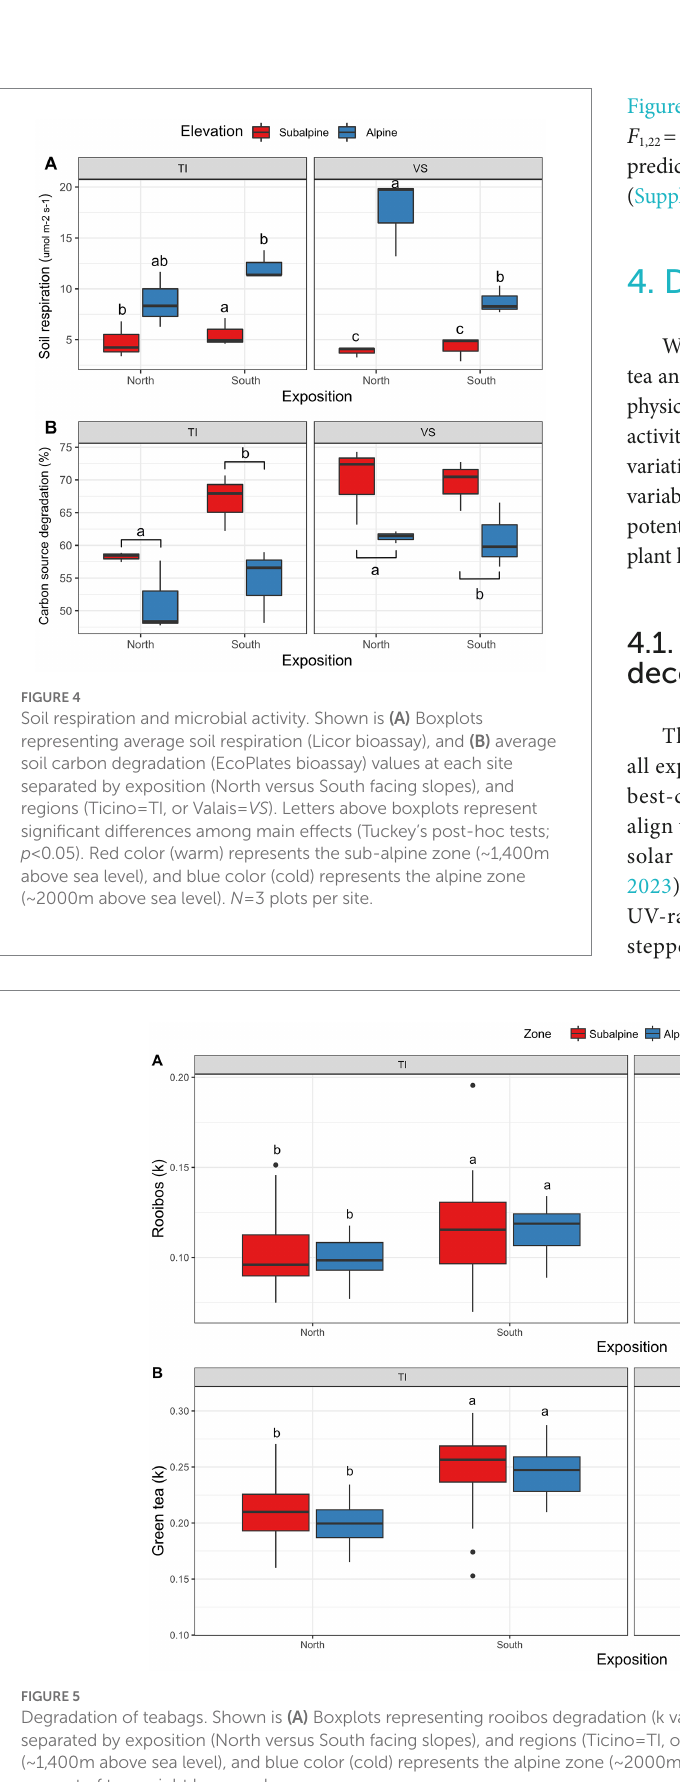
Figure 6A, lm; F 1,22 = 15.98, p < 0.001, and for rooibos tea, Figure 6B, F 1,22 = 7.65, p = 0.01). Moreover, the humidity was the second-best